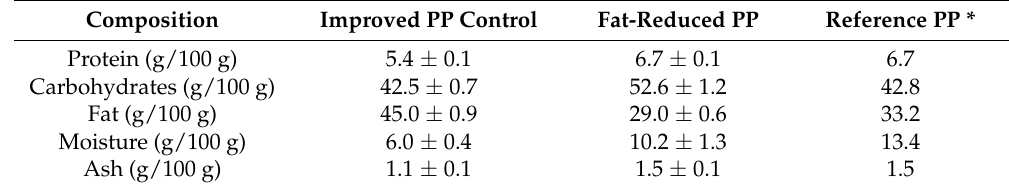
Table 5. Compositional analysis of puff pastry